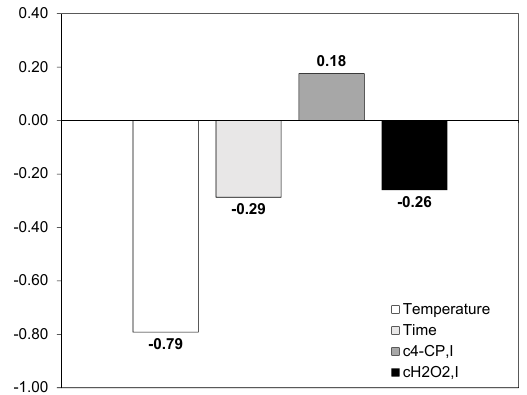
Figure 4. Standardized coefficients of the obtained model.